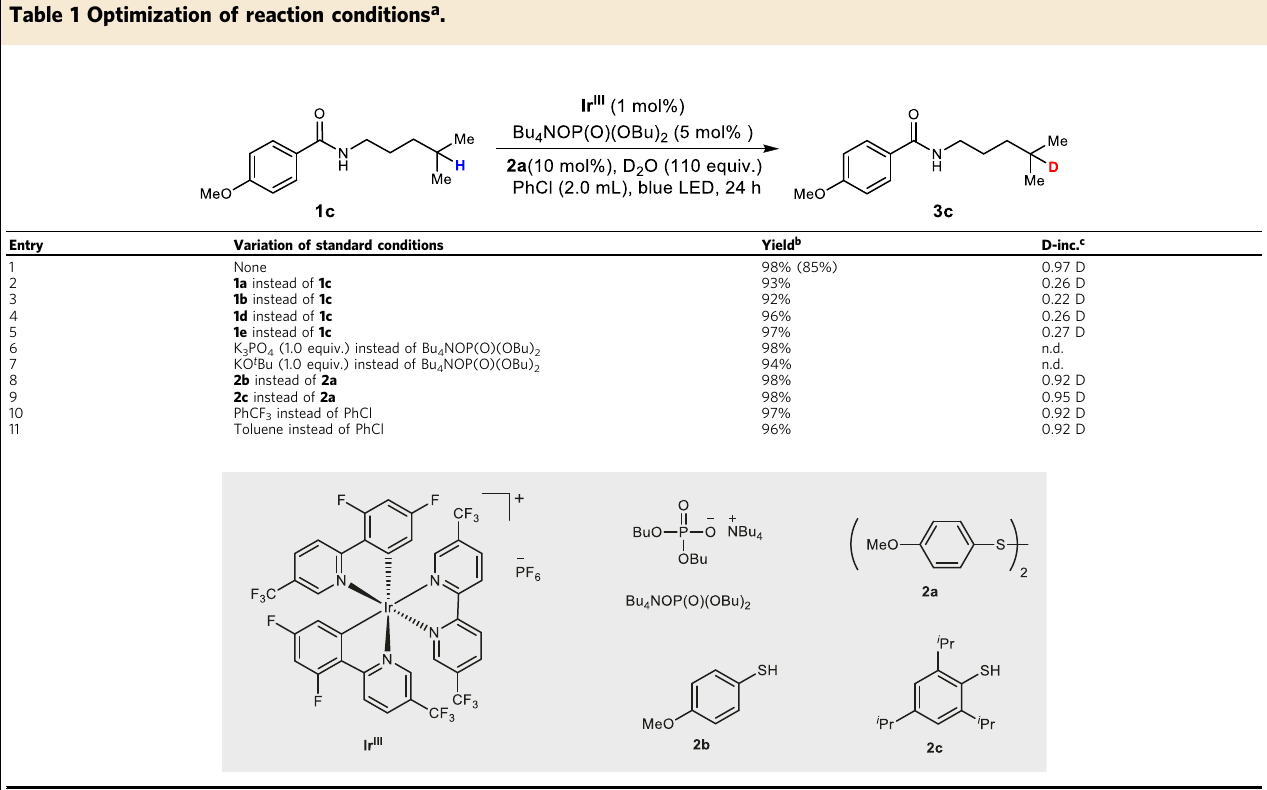
Table 1 Optimization of reaction conditions a